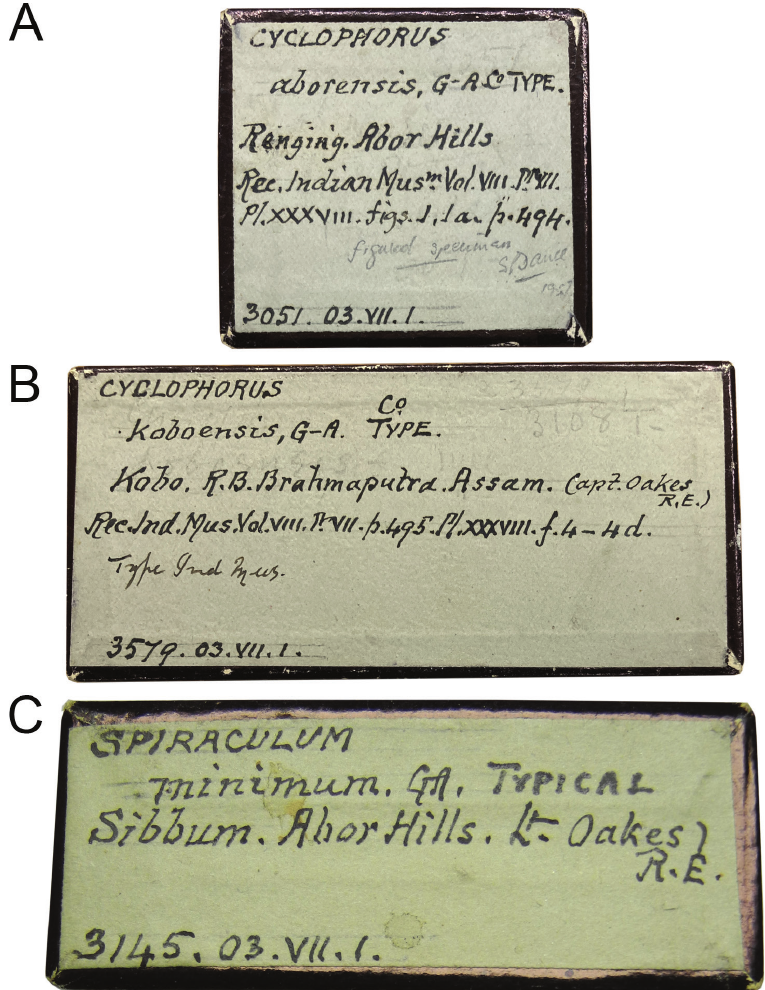
Figure 6. Original labels bearing Godwin-Austen’s handwriting of A Cyclophorus aborensis NHMUK 1903.7.1.3051 with the word “Co-Type” B Cyclophorus ( Glossostylus ) koboensis NHMUK 1903.7.1.3579 with the word “Co-Type”, and C Spiraculum minimum NHMUK 1903.7.1.3145 with the word “Typi- cal” in different